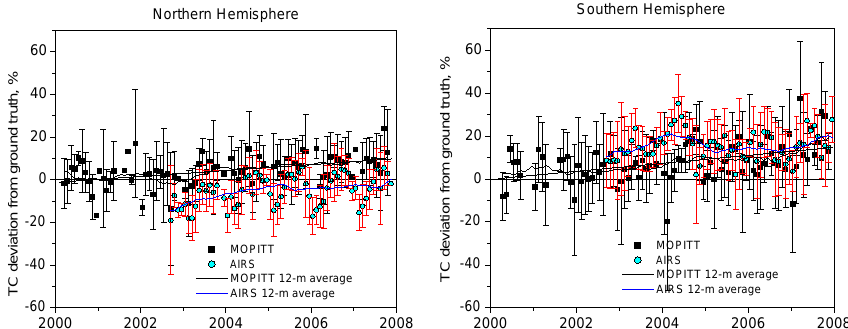
Fig. 5. Temporal stability of two sounders in both hemispheres. Monthly mean deviations of CO TC measured by satellite sounders from those measured by ground-based spectrometers. Vertical bars represent standard deviations (black – MOPITT, red – AIRS). Black and blue lines correspond to 12-month sliding averages; straight lines for MOPITT are linear regressions with slopes (1.4 ± 0.4)% per year (NH) and (1.8 ± 0.4)% per year